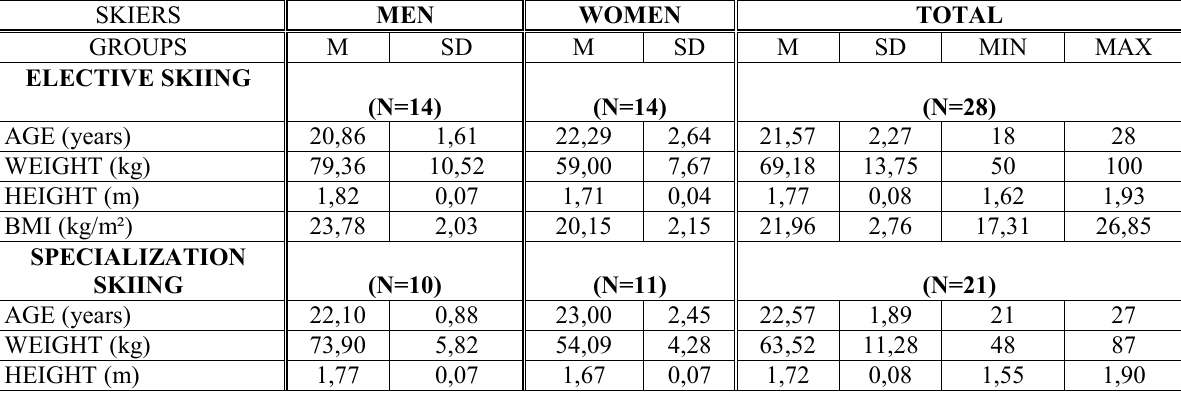
Three groups of skiers and somatometric